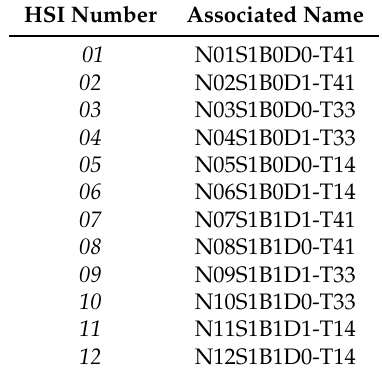
Table 2. Names are coded using the pattern N·S·B·D·-T· where S identifies the setup (1), B the background (black, white), D the position of the gray-scale rows (toward center or toward border) and T the integration